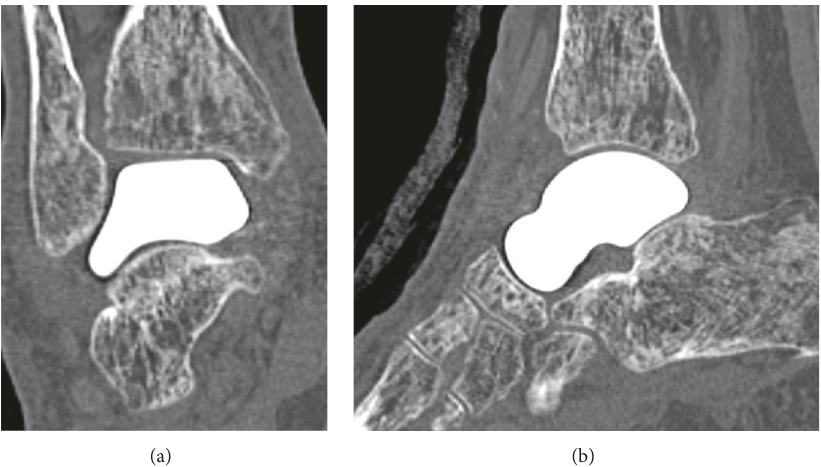
Figure 10: Postoperative CT scans showing that the prosthesis and surrounding bones are well aligned in coronal (a) and sagittal (b) views at 1 year and 6 months after surgery. There is no osteolytic change in the surrounding bone or sinking of the